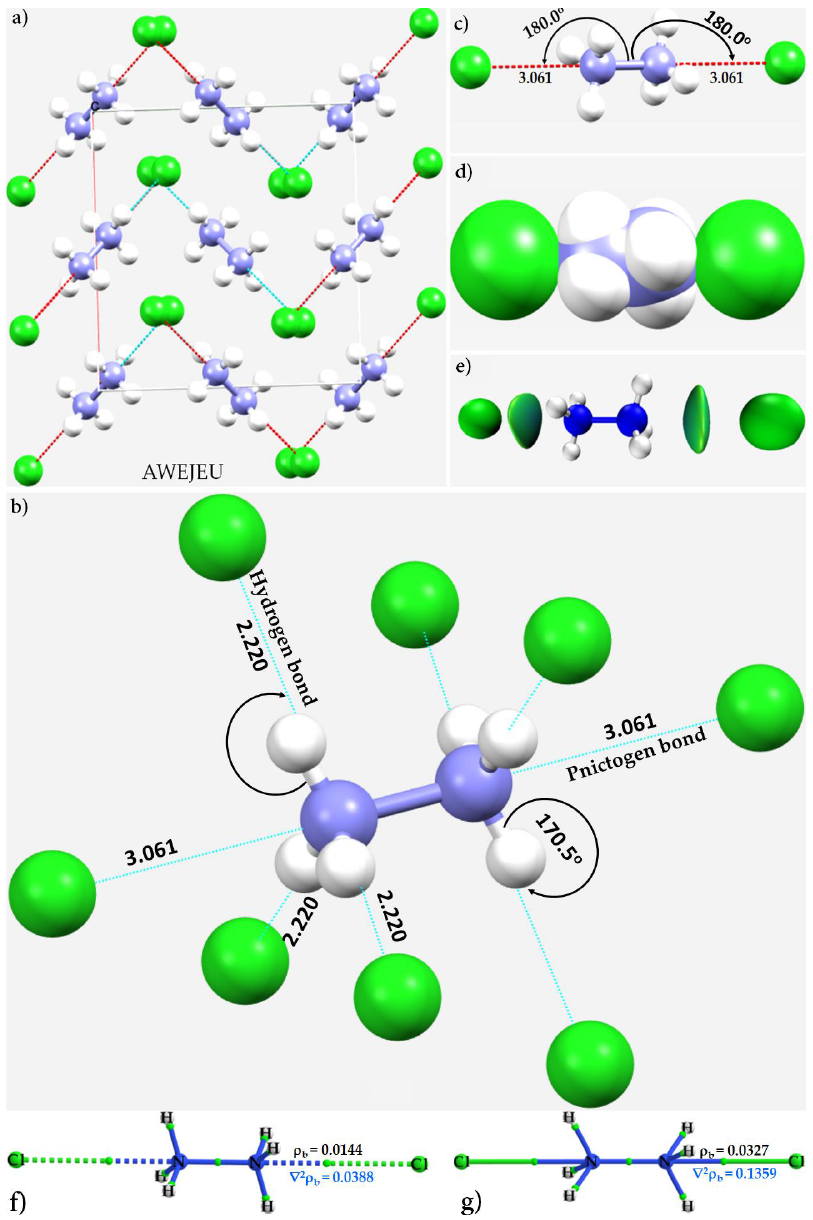
Figure 1. ( a ) The ball-and-stick model of the unit-cell of crystalline diazanediium dichloride, [NH 3 NH 3 ][Cl] 2 ; ( b ) Illustration of N ··· Cl and N–H ··· Cl pnictogen and hydrogen bonds between a single NH 3 NH 32+ dication and surrounding nearest-neighbor Cl − ions in the [NH 3 NH 3 ][Cl] 2 crystal. ( c ) The local geometry of the interaction between two anions and a cation; ( d ) Space-filling model showing overlapping between N and Cl atomic basins in the geometry depicted in ( c ); and ( e ) IGM- δ g based isosurface volume (colored bluish-green) between N and Cl atomic basins between [NH 3 NH 3 ] 2+ and 2Cl − . ( f , g ) QTAIM-based molecular graphs for the [NH 3 NH 3 ][Cl] 2 ion-pair, ob- tained using the extracted geometry of the same ion-pair in the crystal (CSD ref: AWEJEU [81]) and the MP2(fc)/def2-TZVPPD optimized geometry, respectively. Values (in a.u. ) marked in these molecular graphs represent the charge density ( ρ b ) and the Laplacian of the charge density ( ∇ 2 ρ b ) at N ··· Cl bond critical point. Bond paths are in atom color and bond critical points between atomic basins are shown as tiny spheres in green. Bond distances and bond angles are in Å and degrees, respectively. Intermolecular contacts in ( a , b , e ) are colored in cyan and hanging contacts colored in red. N–H ··· Cl hydrogen bonds are not shown between the interacting ions in the crystal in ( a